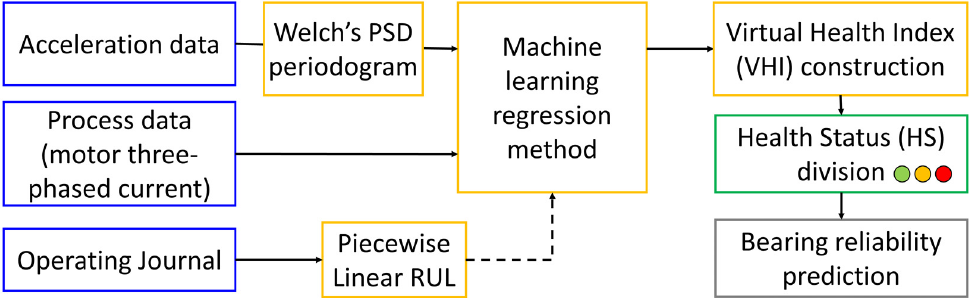
Figure 2. Process flow of the Condition-Based Maintenance of the EVA reactor.